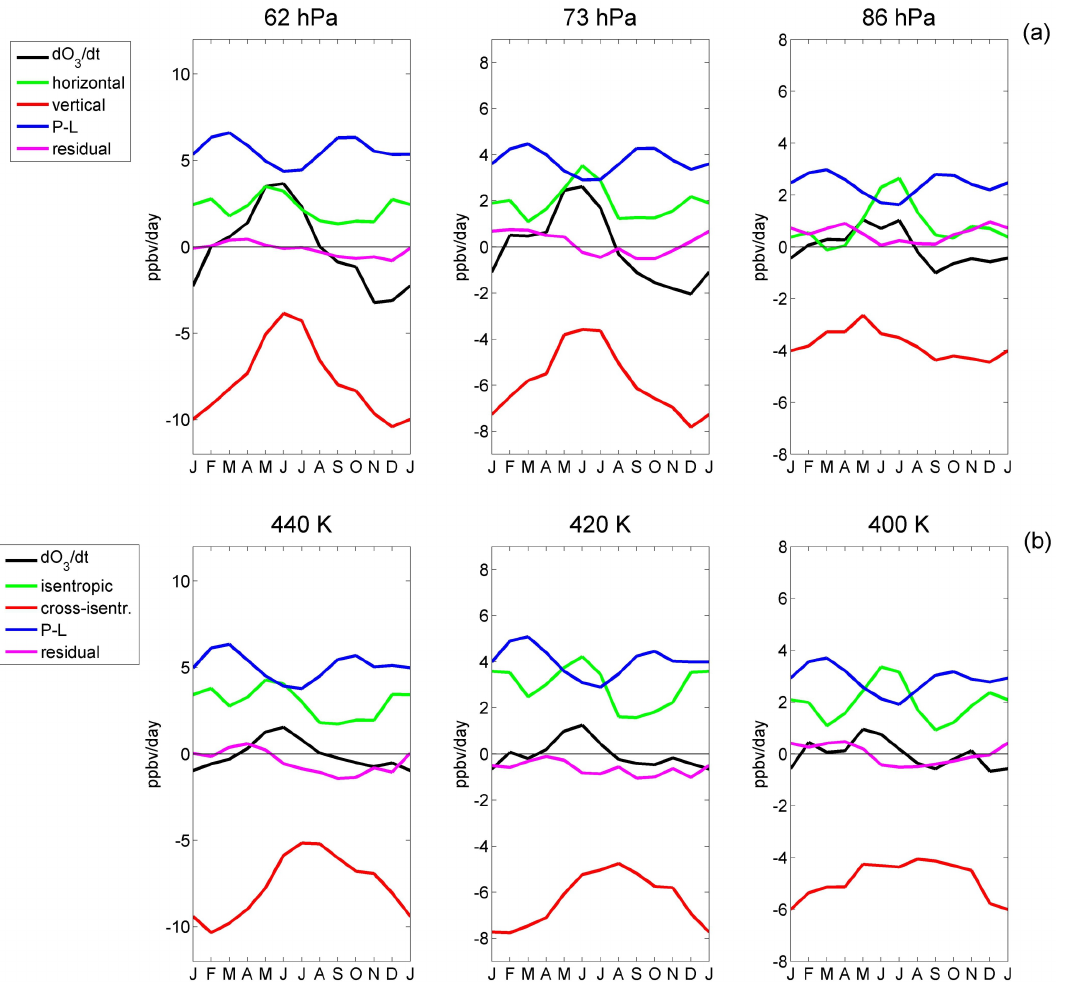
Fig. 8. Mean seasonal cycles (monthly means) of terms in the ozone continuity equation averaged over 18 ◦ S–18 ◦ N on pressure levels (Eq. 5, a ) and isentropic levels (Eq. 6, b